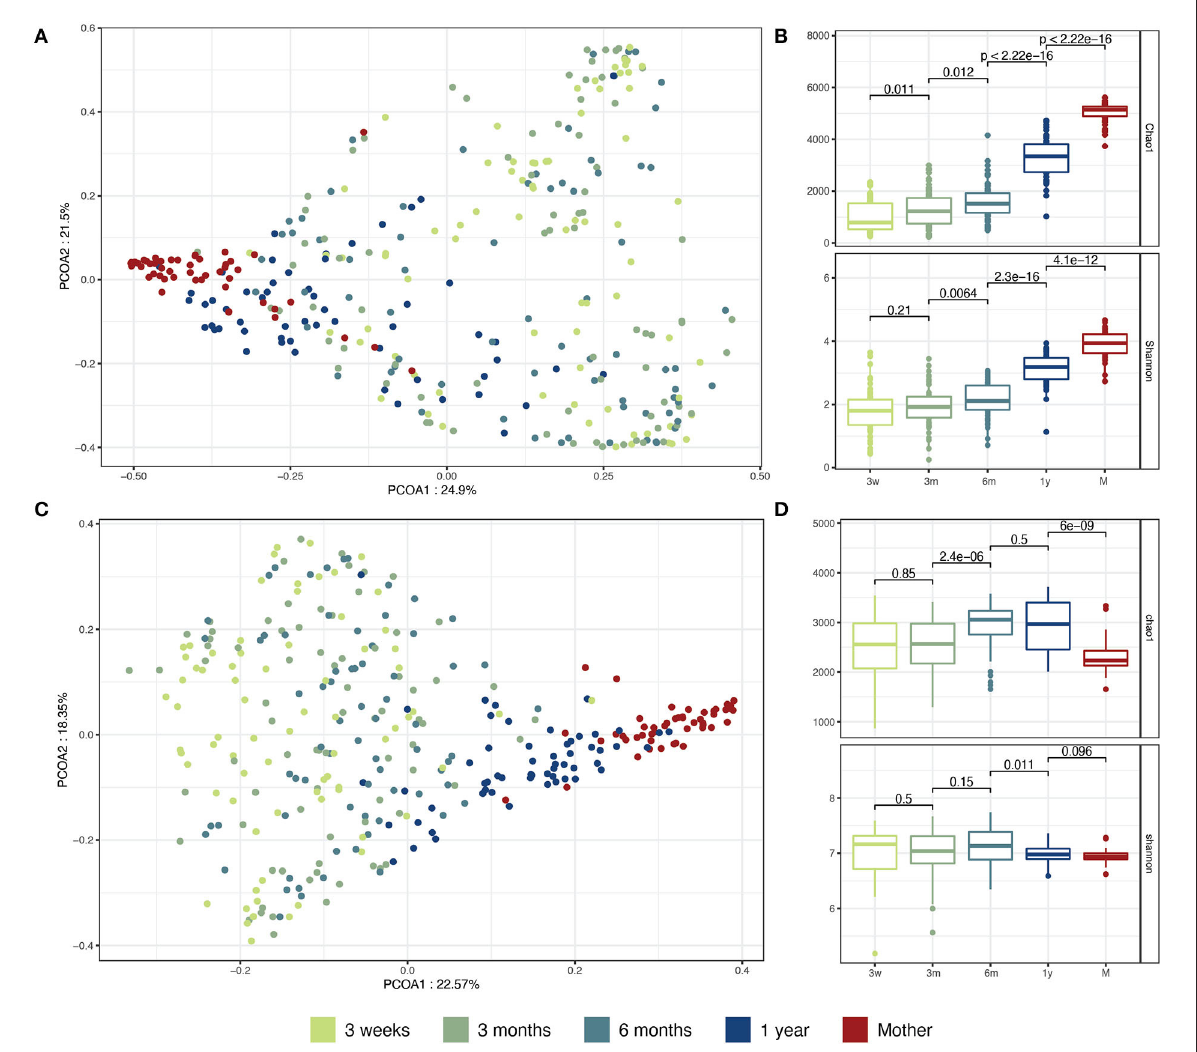
FIGURE1 Taxonomic and functional maturation of infant microbiota during the first year of life. (A) PCoA on genus level taxonomic profiles. Taxonomic profiles were aggregated at the genus level. The beta diversity Bray-Curtis distance was computed between sample pairs and plotted as a PCoA. (B) Taxonomic alpha diversity and richness. Taxonomic profiles were aggregated at the species level. The Shannon alpha-diversity index and the Chao1 richness index were computed for each sample. (C) PCoA on KO functional profiles. The KO profiles were normalized as count per million reads. The beta diversity Bray-Curtis distance was computed between each sample pair and plotted as a PCoA. (D) Functional alpha diversity and richness. The KO profiles were normalized as previously described. The Shannon alpha-diversity index and the Chao1 richness index were computed for each sample. The comparisons between groups were conducted by unpaired Wilcoxon